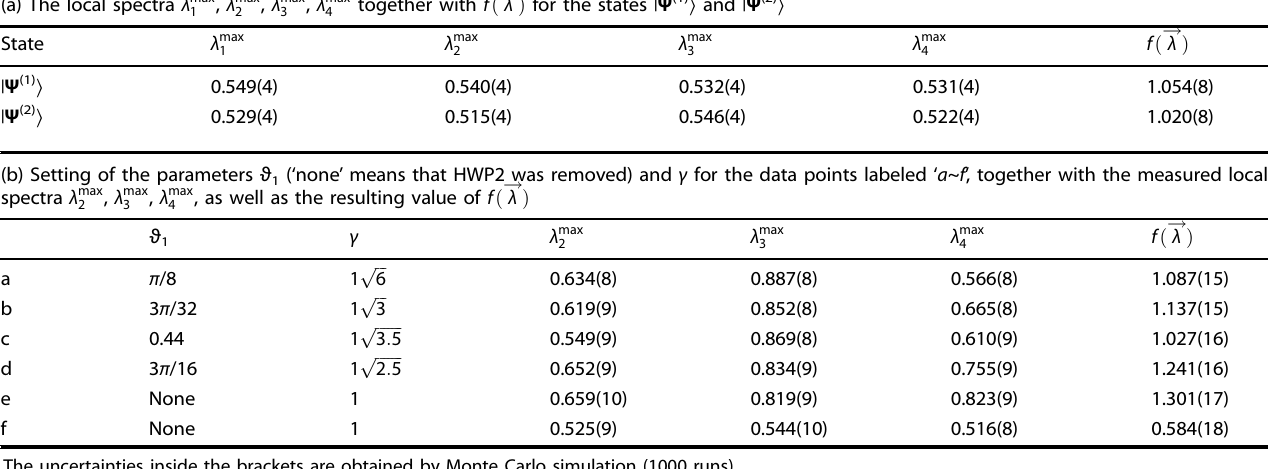
Table 1. Local spectra of the original four qubit states and the spectra after applying local operations (a) The local spectra λ max